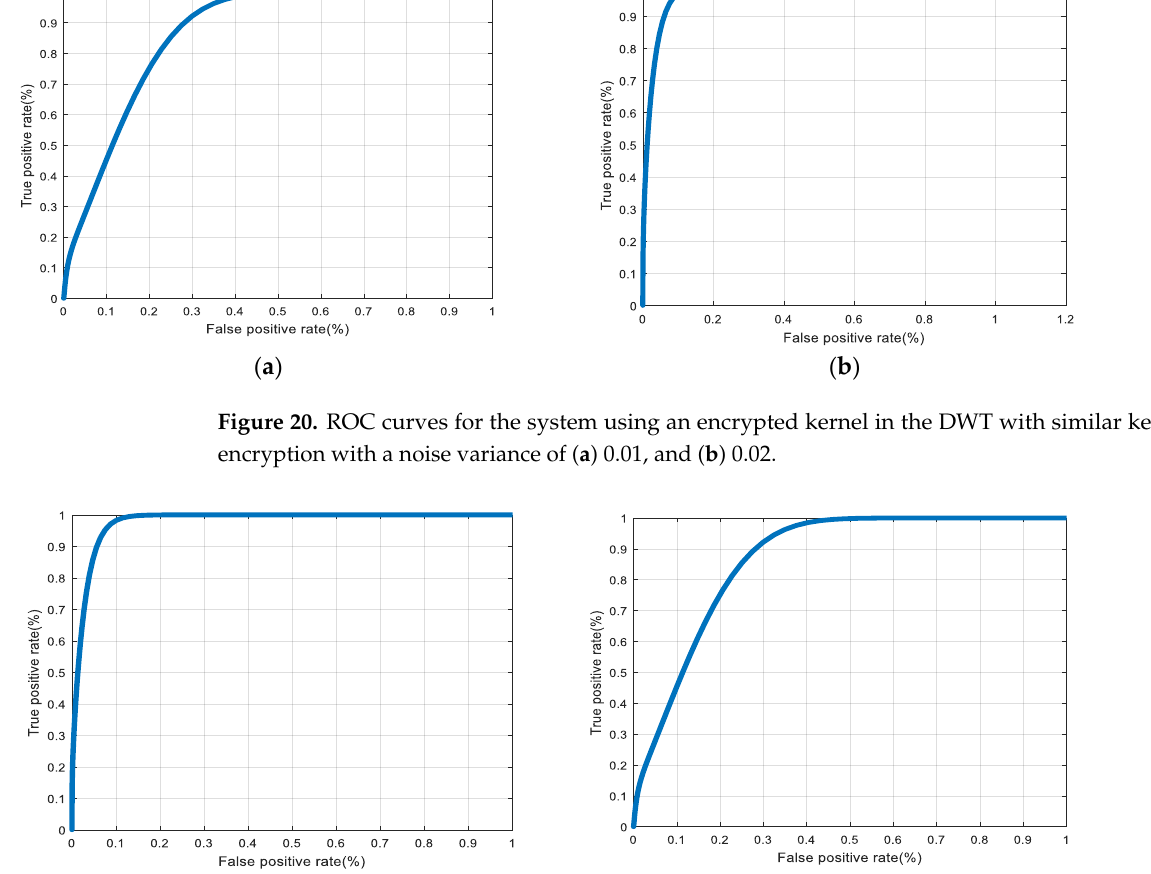
Figure 19. ROC curves for the system using an encrypted kernel with the IWT with different keys of encryption with a noise variance of ( a ) 0.01, and ( b ) 0.02.